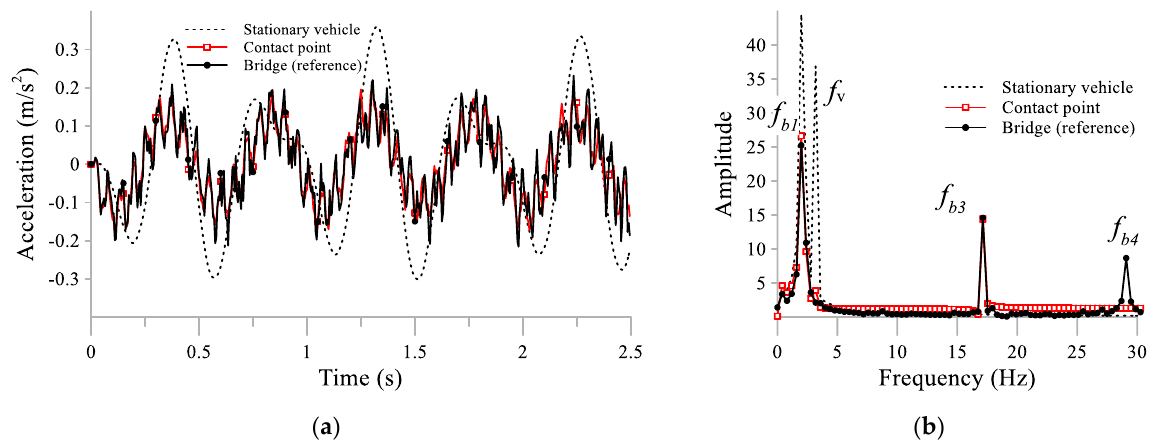
Figure 20. Dynamic responses due to a moving vehicle mass of 7200 kg ( a ) and the acceleration response of the 3.18-Hz stationary vehicle, its contact-point, and the bridge, along with ( b ) the acceleration spectra.